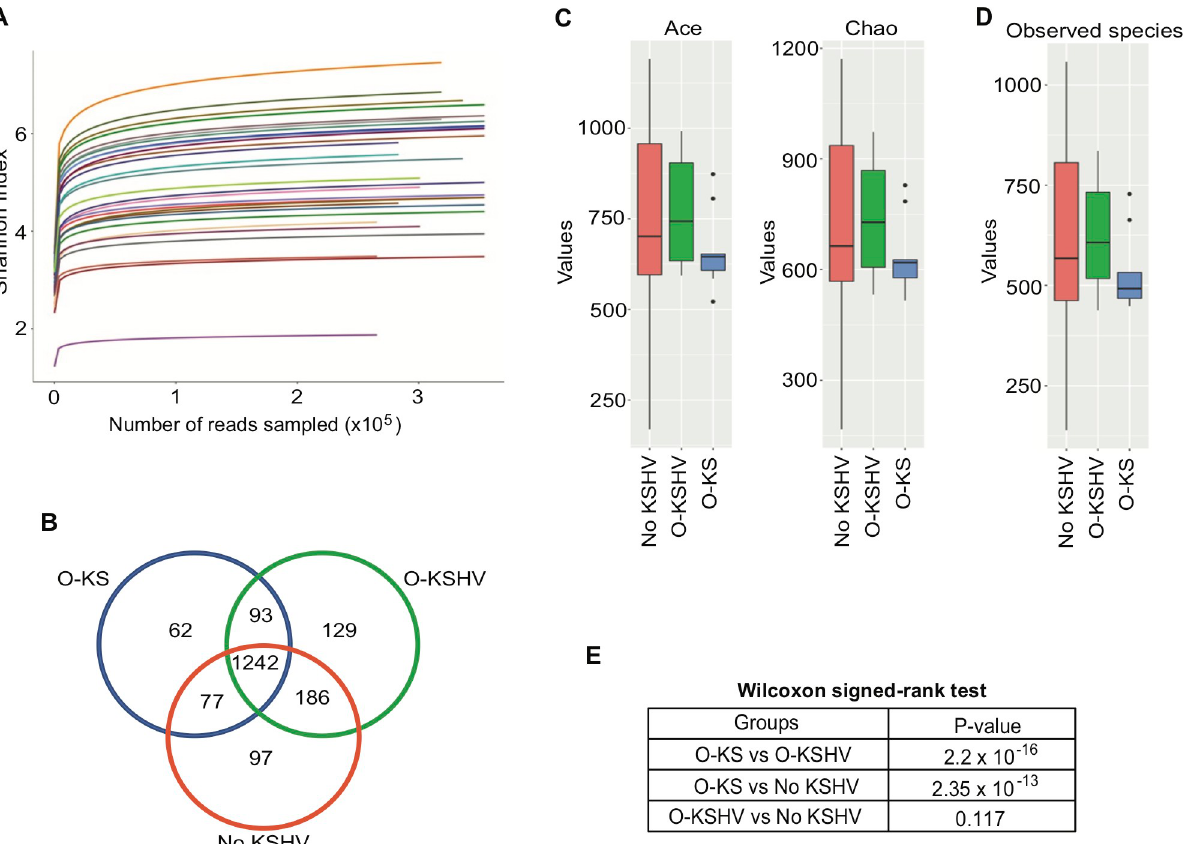
Fig 2. The richness and diversity of microbiota in three studied groups of HIV/KSHV-coinfected individuals. (A) Shannon index measuring how evenly OTUs are distributed in a sample by showing the numbers of reads for all specimens at species level. Each specimen is represented by a color. (B) Venn diagram of OTUs identified in the three studied groups at species level. (C) Diversity across specimens at species level for the three studied groups examined with the Observed Species Algorithm. (D) The richness across different specimens at species level in all studied groups examined with the Ace and Chao Algorithms. (E) Examination of the differences across all three studied groups at species level using Wilcoxon signed-ranked test.